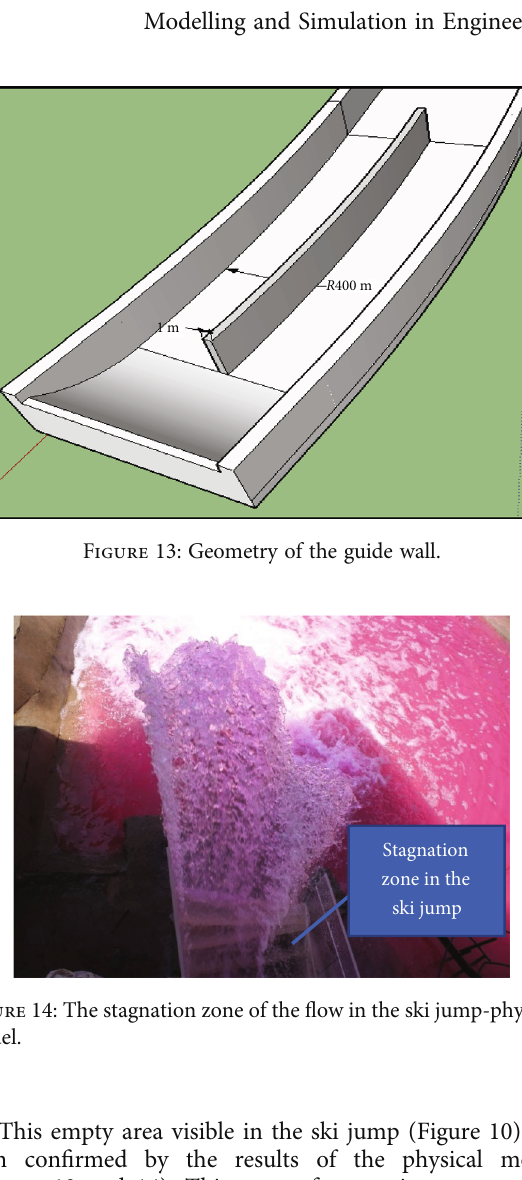
Figure 12: Illustration of the dissymmetry of the fl ow in the chute due to the curvature R = 400 m [16].